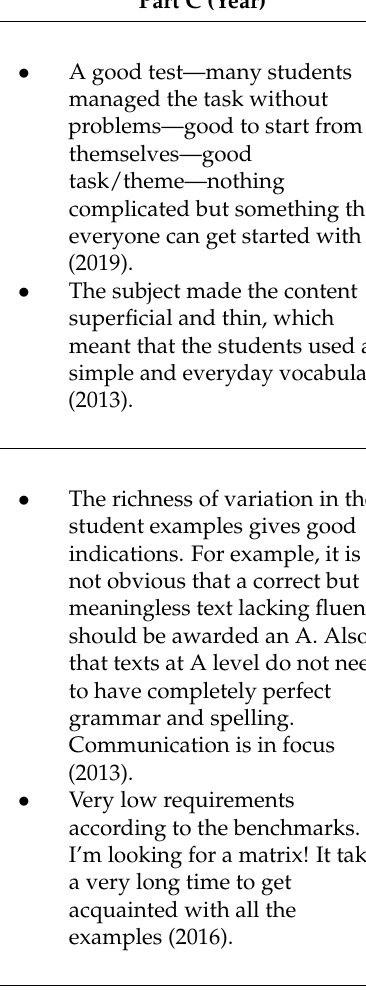
Table 7. Examples of teacher comments related to the themes Content, Rating and Consequence, including an evaluative dimension (2013, 2016 and 2019 Year 6 EFL questionnaires).